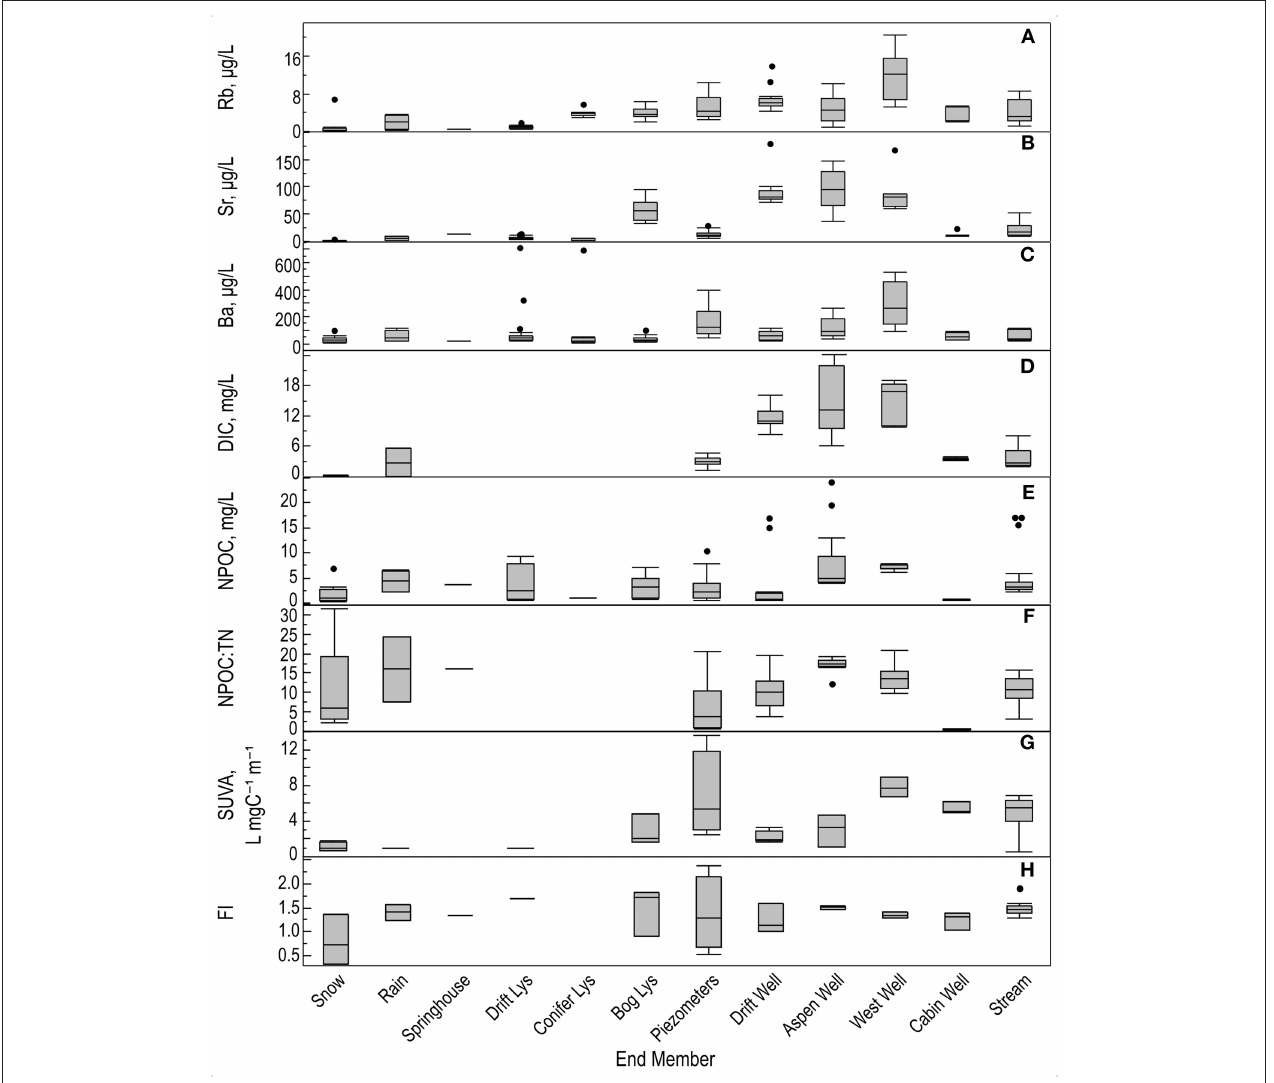
FIGURE 3 | Medians, ranges, and interquartile ranges for (A–C) tracers used in EMMA, (D) DIC, (E) DOC, (F) C:N ratio, (G) SUVA, and (H) FI (see section Results for details) for all potential water sources in RME. Note that only one sample was collected from the Springhouse drift. Missing boxplots for lysimeters are due to insufficient sample to run all